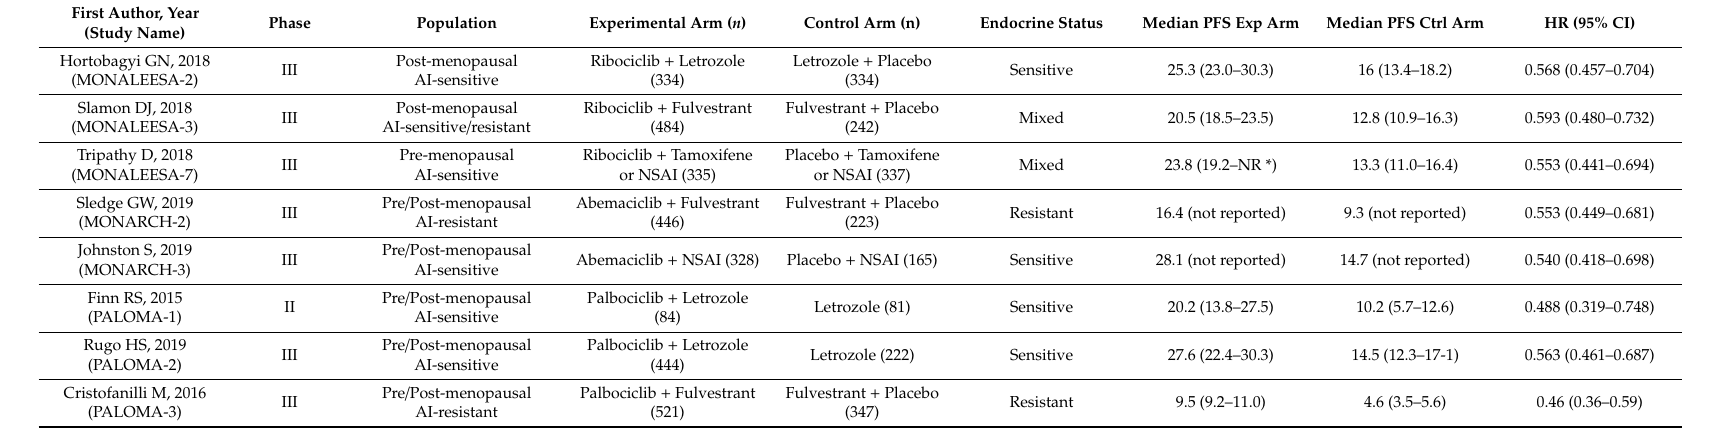
Table 1. Characteristics of included